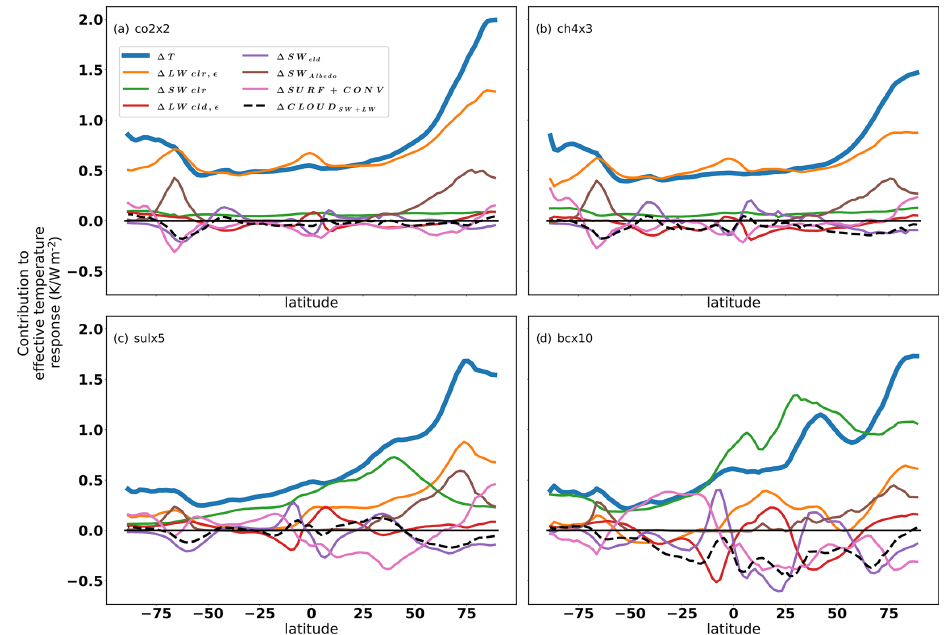
Figure 5. Zonal-average multimodel-mean effective temperature response (thick blue lines) and its decomposition into different energetic terms (thin colored lines) for different climate forcers. Panel (a) shows co2x2, panel (b) shows ch4x3, panel (c) shows sulx5, and panel (d) shows